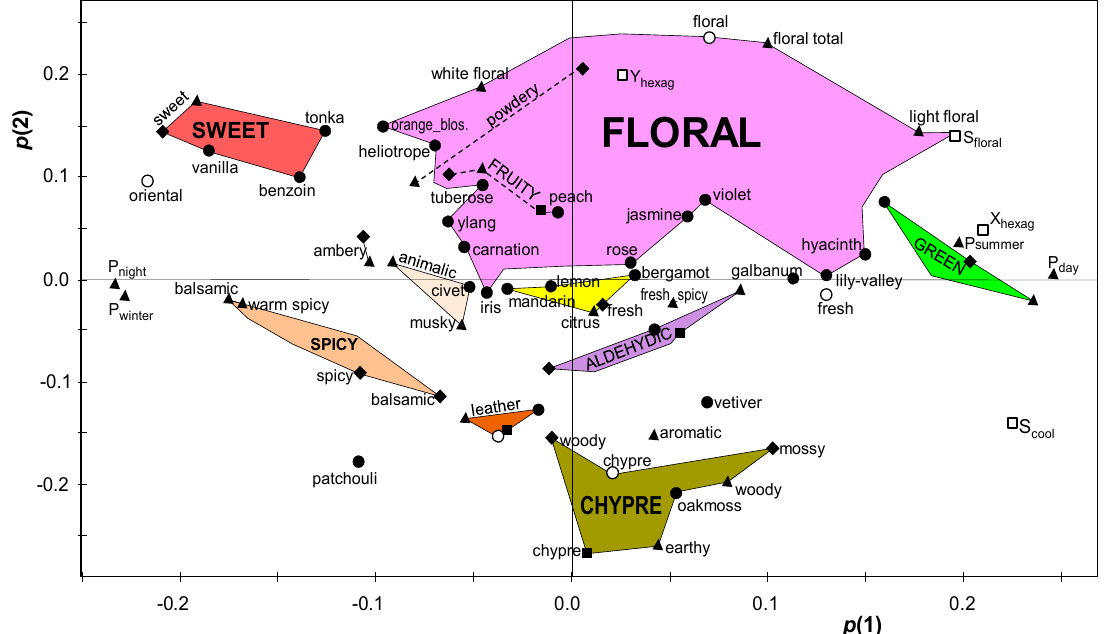
Figure 2. Loading plot ( p (2) versus p (1)) of the PCA applied to the olfactory profiles (73 variables) obtained for the set of 140 perfumes. Odor descriptors obtained from Fragrantica and additional catalogs (see Table 1 for list of variables included and point codes). Equivalent or related odor descriptors are joined with lines. Polygons are colored to highlight the main olfactory